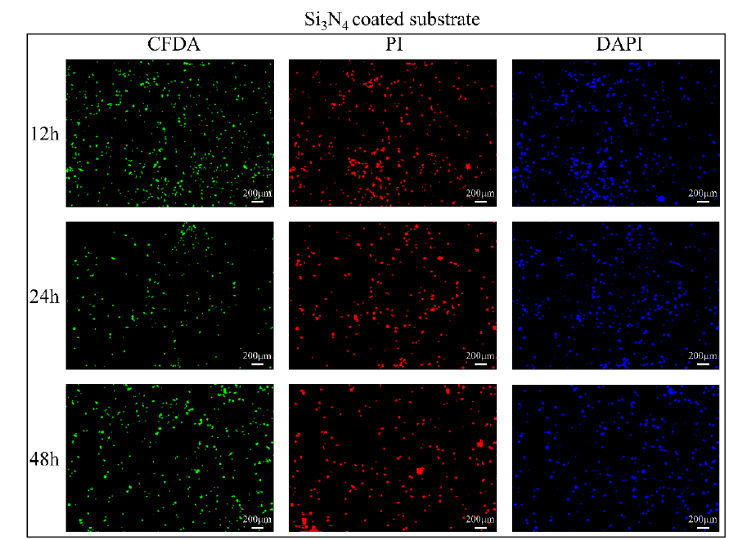
Figure 7. Fluorescence micrographs of the Si 3 N 4 -coated PE substrate after bacteria testing. Green stain (CFDA) marked the live bacteria, the red stain (PI) the dead bacteria, and the blue stain (DAPI) the bacterial cells’ nuclei.